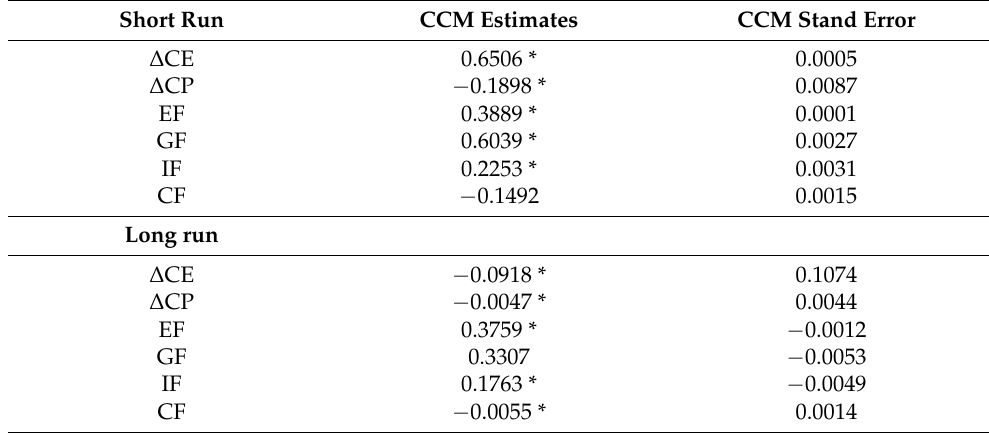
Table 5. CS ARDL